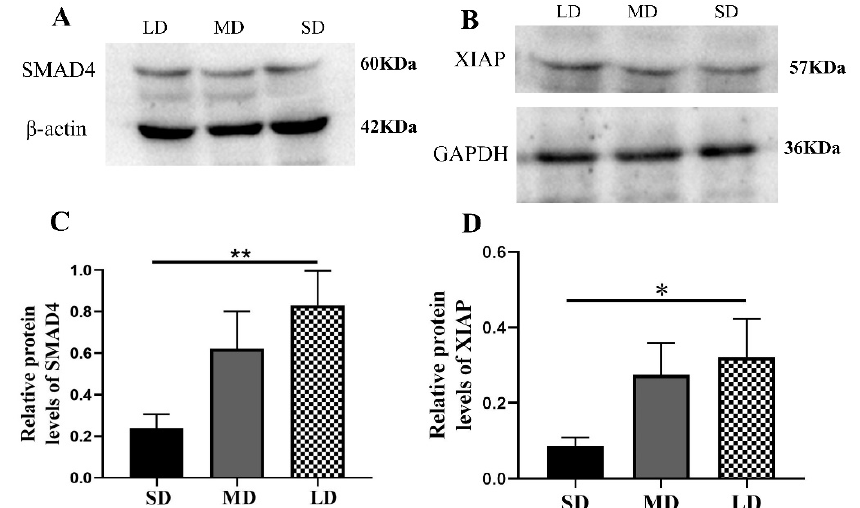
Figure 8. Levels of the Smad signaling pathway protein expression in the ovaries of Phodopus sungorus under three photoperiod conditions. ( A , B ) Representative immunoblots of the key SMAD4 and XIAP proteins and internal reference proteins ( β -actin and GAPDH). ( C , D ) Relative protein expression of SMAD4 and XIAP. Values are means ± SEM. n = 8. SD, short daylight; MD, moderate daylight; LD, long daylight. * p < 0.05, ** p < 0.01.